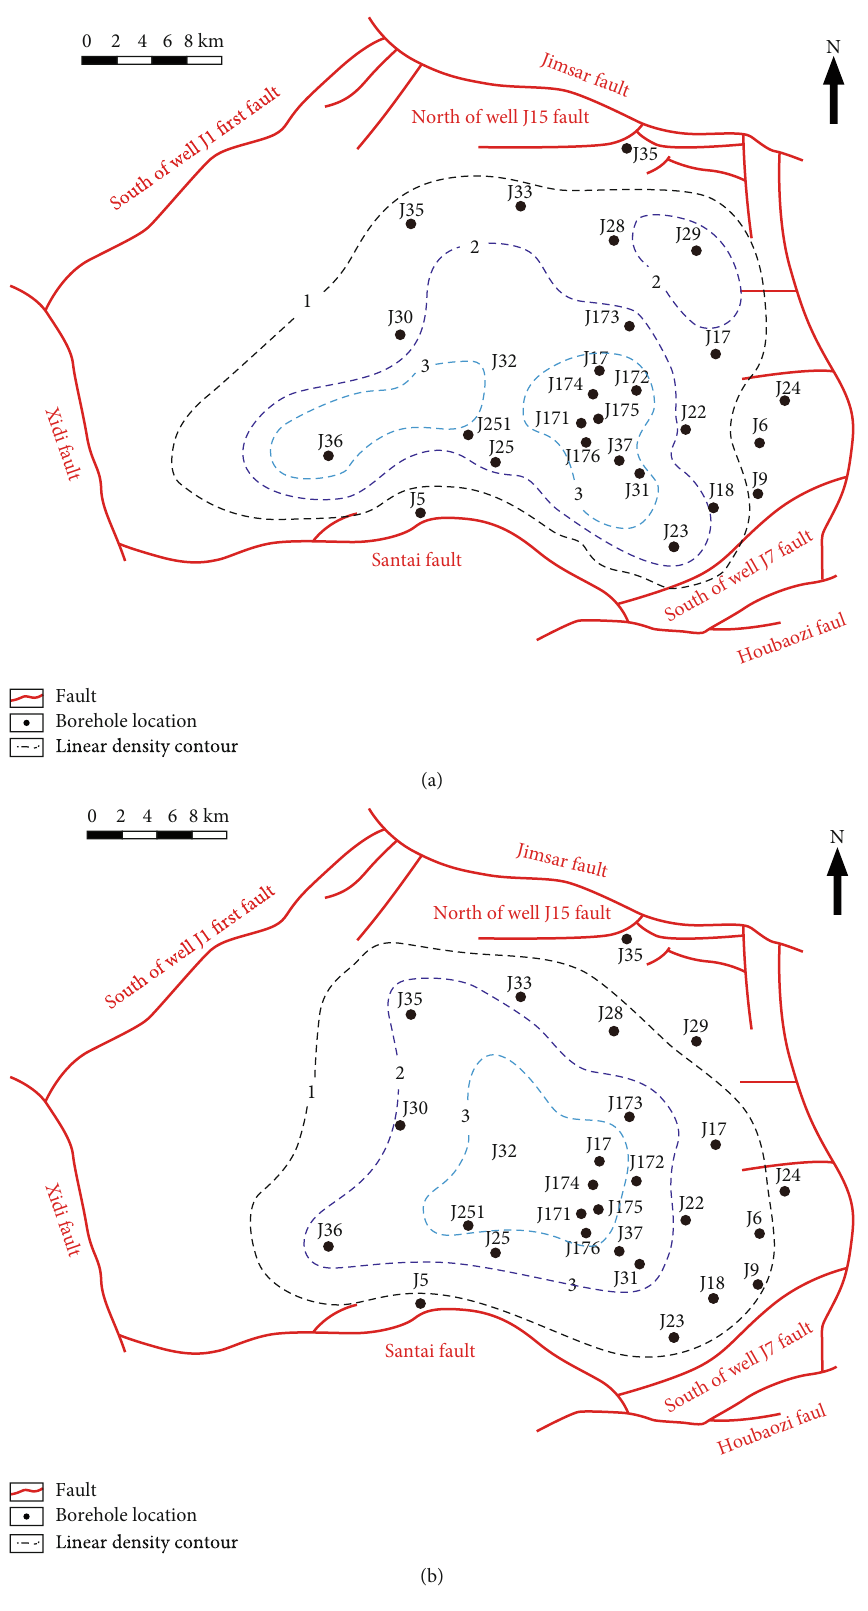
Figure 7: (a) Linear density prediction map of bedding fractures in the upper sweet spot of Lucaogou formation in Jimsar sag. (b) Linear density prediction map of bedding fractures in the lower sweet spot of Lucaogou formation in Jimsar